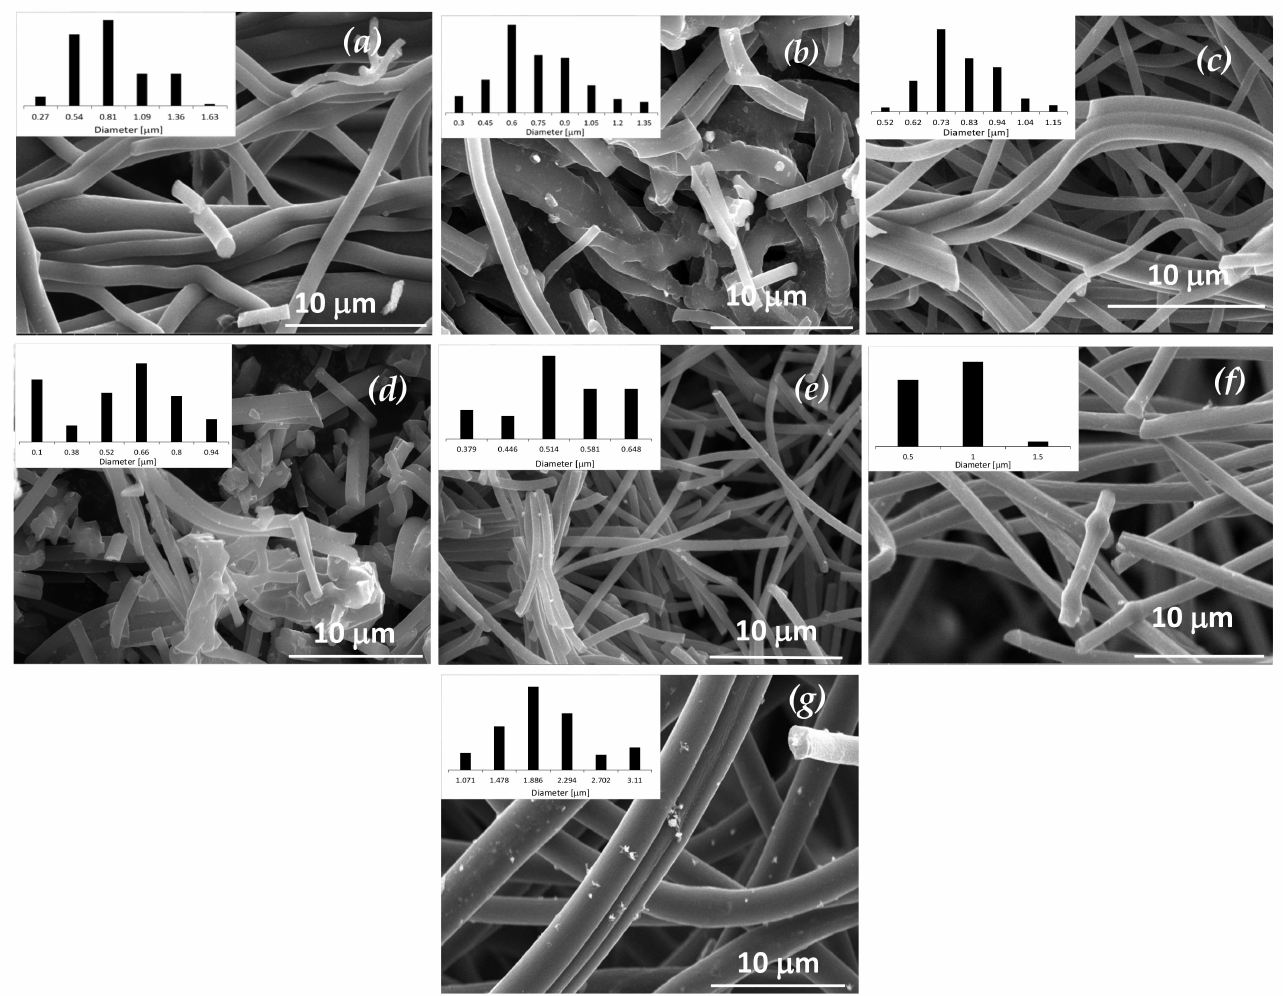
Figure 3. SEM images of samples: ( a ) CF1, ( b ) 1% Pd/CF1, ( c ) CF2, ( d ) 1% Pd/CF2, ( e ) CF3, ( f ) CF4, and ( g )